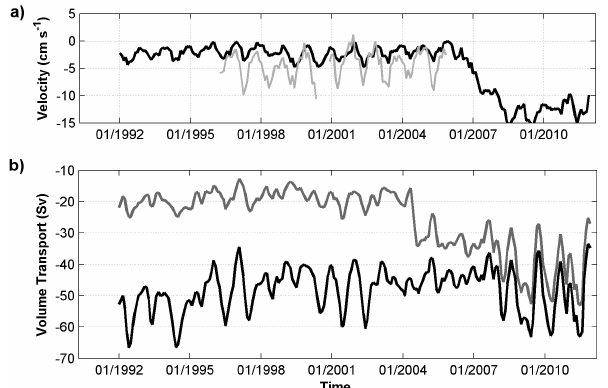
Figure 15. (a) Comparison between the monthly time series of the current meter (gray) and ECCO2 (black) zonal velocity (cms − 1 ) at ∼ 2000m based on the M233 position (see mooring positions in Fig. 1); (b) monthly ECCO2 time series of volume transport (Sv) in Section IV considering the entire water column (black line) and only the AABW layer (gray line).